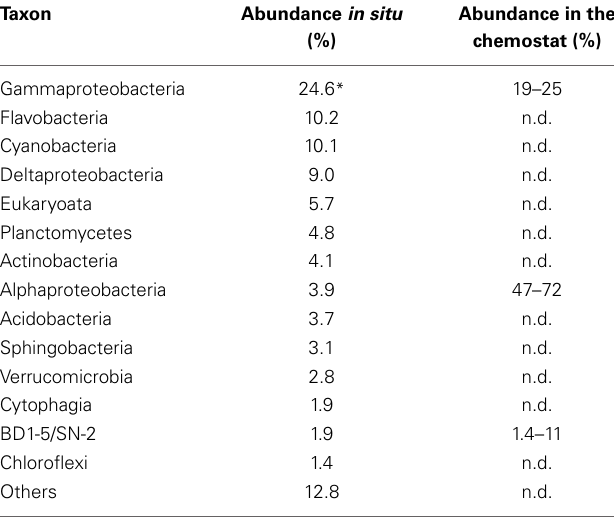
Table 4 | Comparison of population abundances for the selected microbial community (based on metagenomics/FISH) and the sediment community composition in situ (based on sequencing reads encoding 16S rDNA